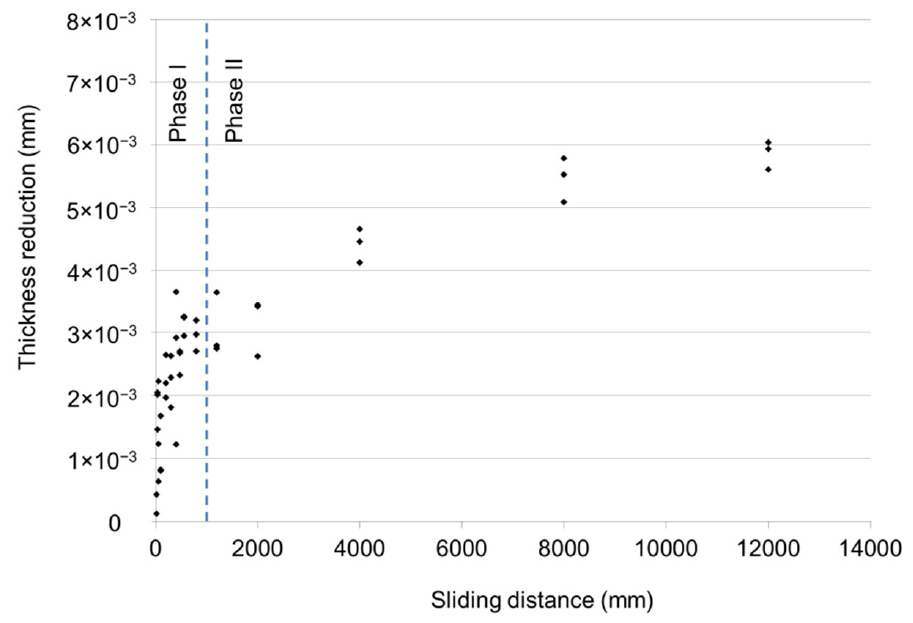
Figure 9. Thickness reduction of the spherical parts with “sphere on plane” arrangement.